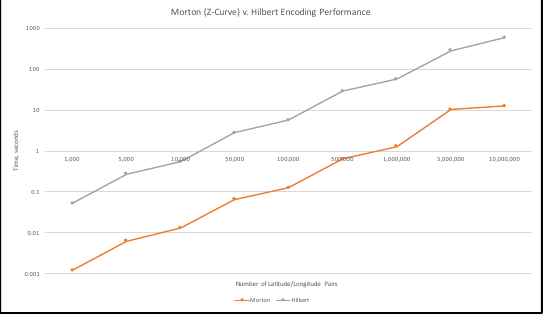
Figure 9. Comparison of Encoding Times for Geohash and Hilbert SFC